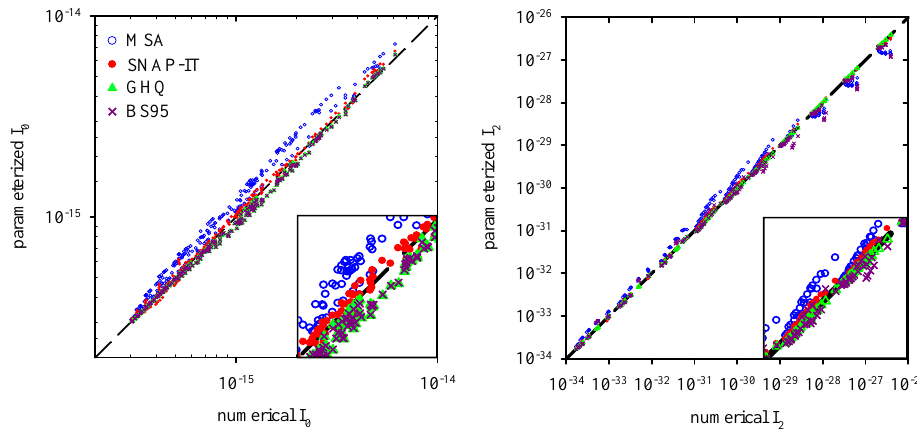
Figure 7: Comparison between various intra-modal Brownian coagulation rates from MSA (blue Fig. 7. Comparison between various intramodal Brownian coagulation rates from MSA (blue open circles), SNAP-IT (red dots), Gauss– Hermite quadrature (GHQ: green triangles), and BS95 (purple crosses). Left: rates for I 0 (unit: 1s − 1 ); right: rates for I 2 (unit: open circles), SNAP-IT (red dots), Gauss-Hermit quadrature (GHQ; green triangles), and BS95 m 2 particle − 1 s − 1 ). At the lower right corner of each panel is a close-up of the central section. All rates have been normalized by total number (purple crosses). Left: rates for (cid:1835) (unit: 1/s); Right: rates for (cid:1835) (unit: m 2 /particle/s). At the (cid:2868) (cid:2870) lower right corner of each panel is a zoom up of the central section. All rates have been normalized by total number concentration.